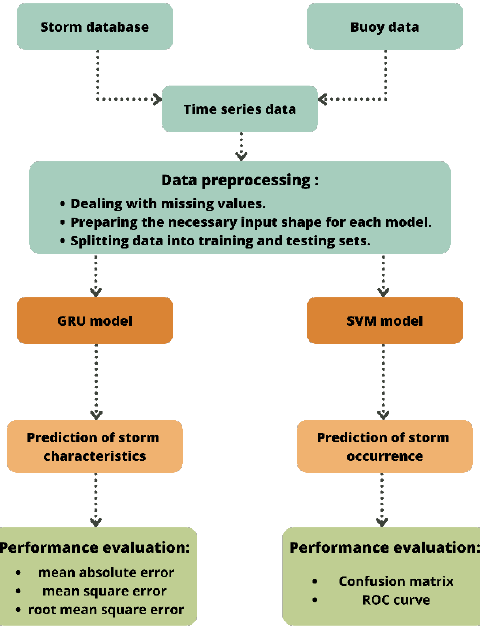
(Figure 2): The first one aims to predict the different characteristics of storms (wind speed, pressure, humidity, temperature, and wave height), which represents a univariate time-series prediction, and the second part focuses on predicting the occurrence of storms based on their characteristics.